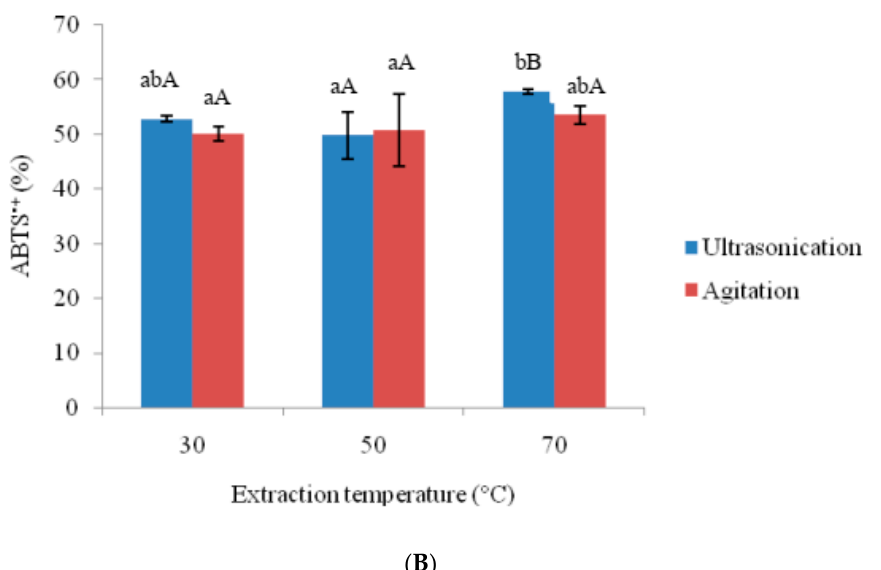
Figure 3. Effects of ultrasonication and agitation on antioxidant activities of amaranth extract. ( A ) DPPH + ( B ) ABTS + . a-b Means with same subscript alphabets are not significantly different ( p ≤ 0.05) between each extraction method. A-C Means with same subscript alphabets are not significantly different ( p ≤ 0.05) among different temperatures in each extraction method.